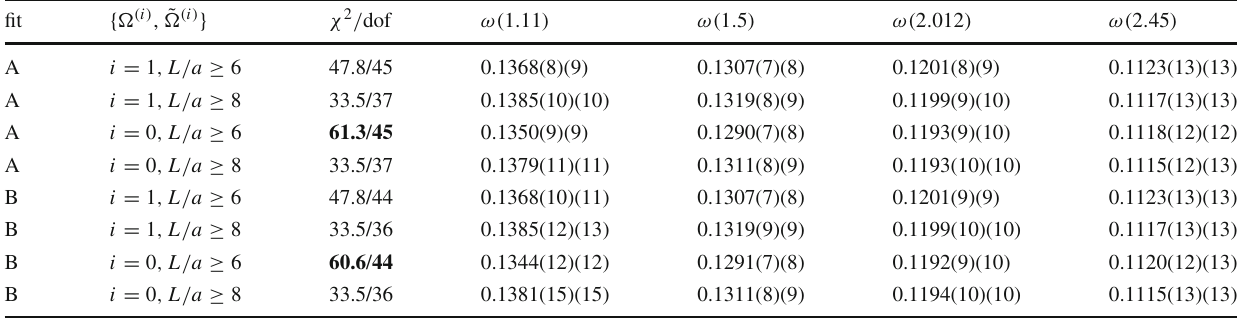
Table 8 Results of the combined fits A and B for (cid:7) ( i ) ( u , a / L ) and ˜ (cid:7) ( i ) ( u , a / L ) with ( i = 1) and without ( i = 0) improvement. The 2 errors given are the statistical and the total error, respectively, where the latter includes an estimate of the remnant uncertainty due to linear a -effects